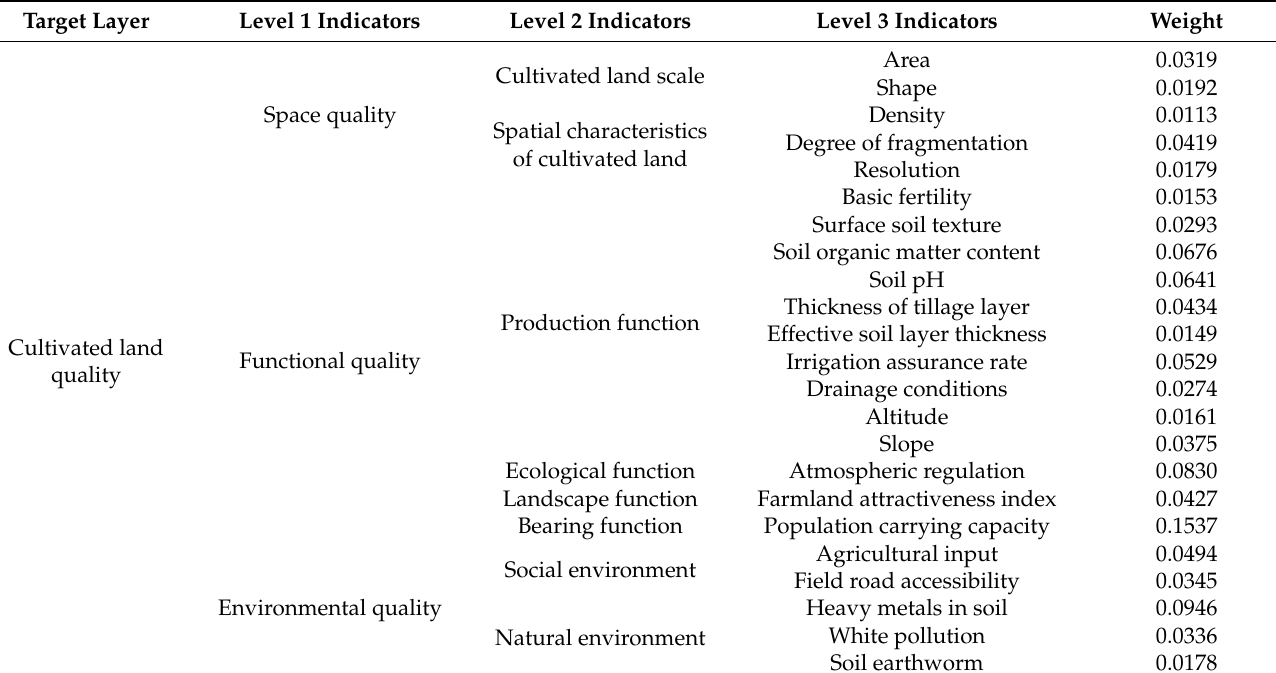
Table 2. Cultivated land space–function–environmental quality evaluation